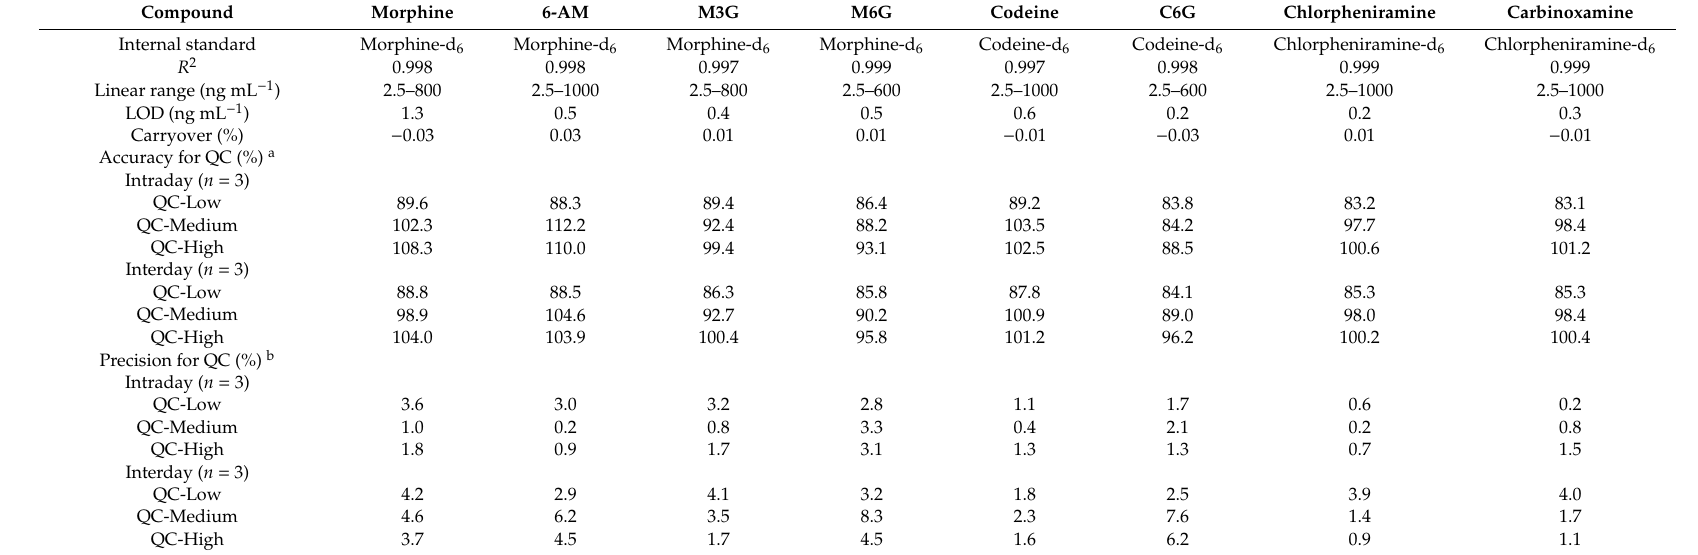
Table 1. Internal standards, correlation coe ffi cients, calibrated linear ranges, limits of detections (LODs), carryovers, accuracies, and precisions with these analytes.